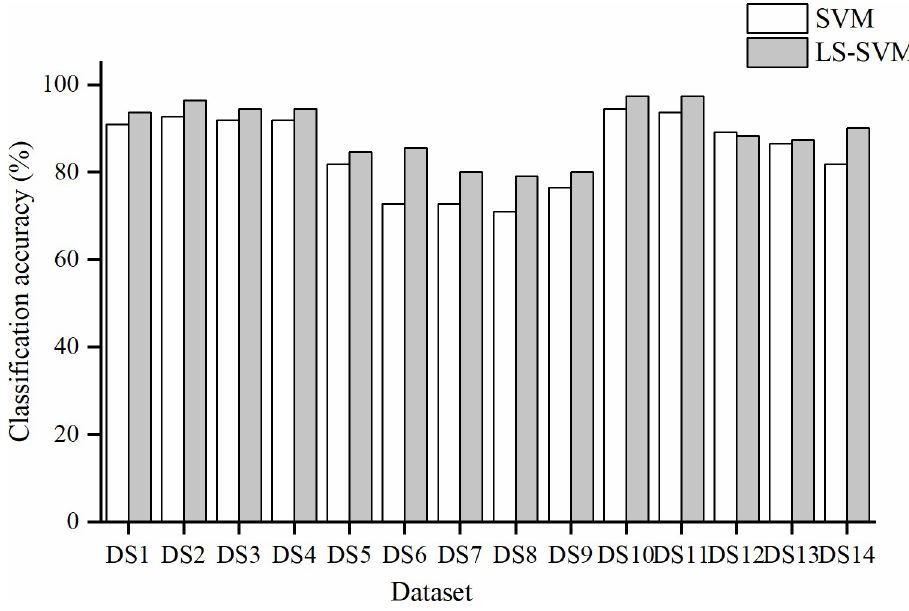
Fig 8. Performance comparison of SVM and LS-SVM